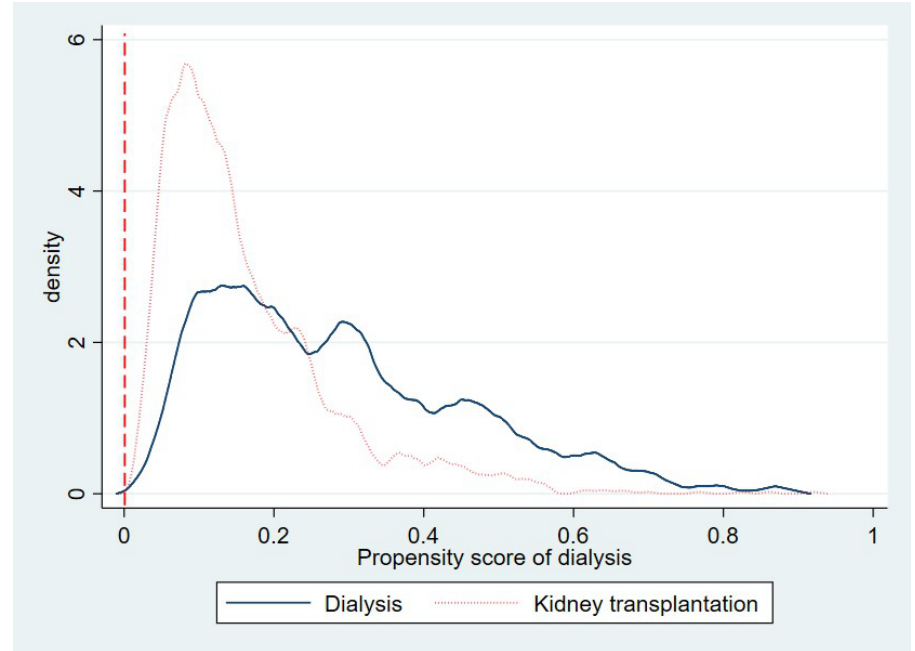
Figure 1. Overlap plot by treatment groups for baseline analysis—the probability of being in the dialysis group.